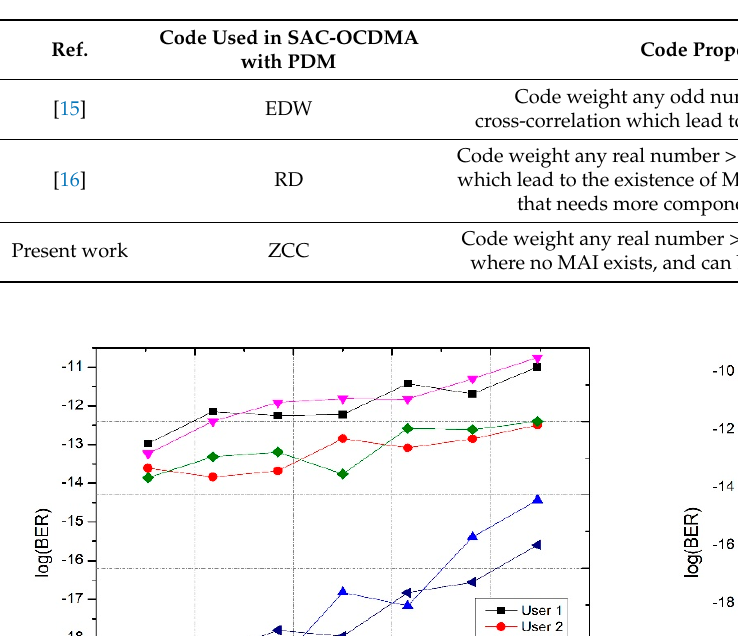
Table 8. Comparison between proposed system using ZCC and previous systems using different codes.